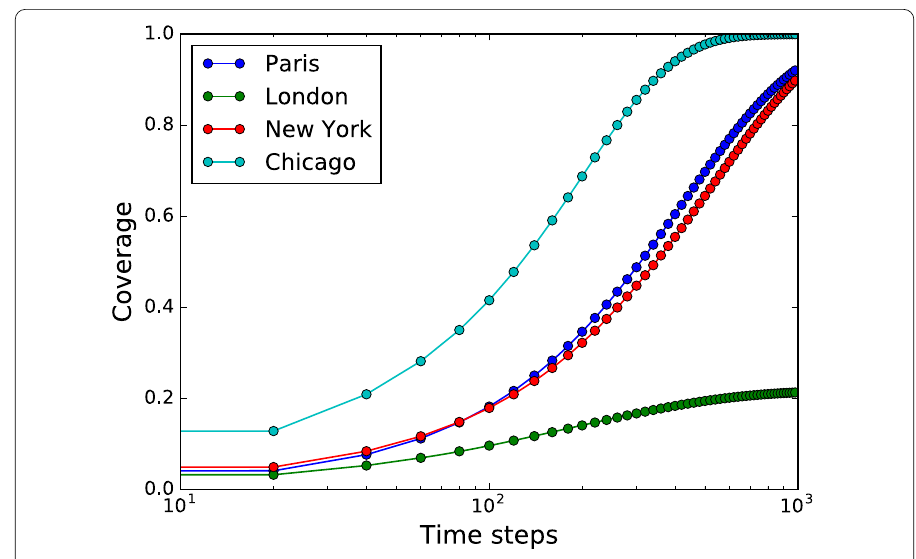
Figure 5 Coverage convergence of the multi-modal transportation networks of Paris, London, New York City, and